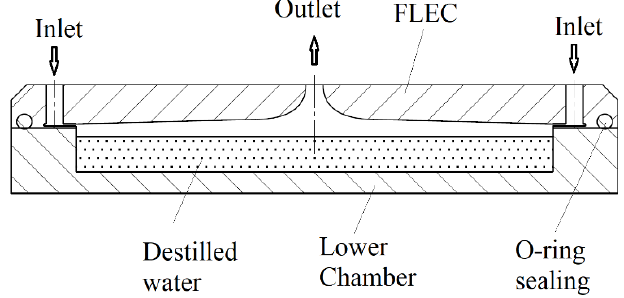
Figure 5. FLEC filled with distilled water.